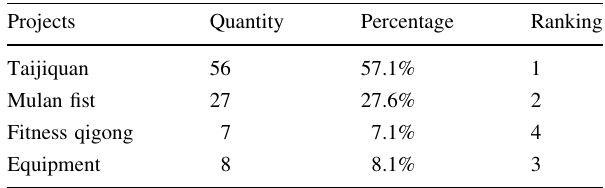
Table 2 Residents participate in martial arts fitness